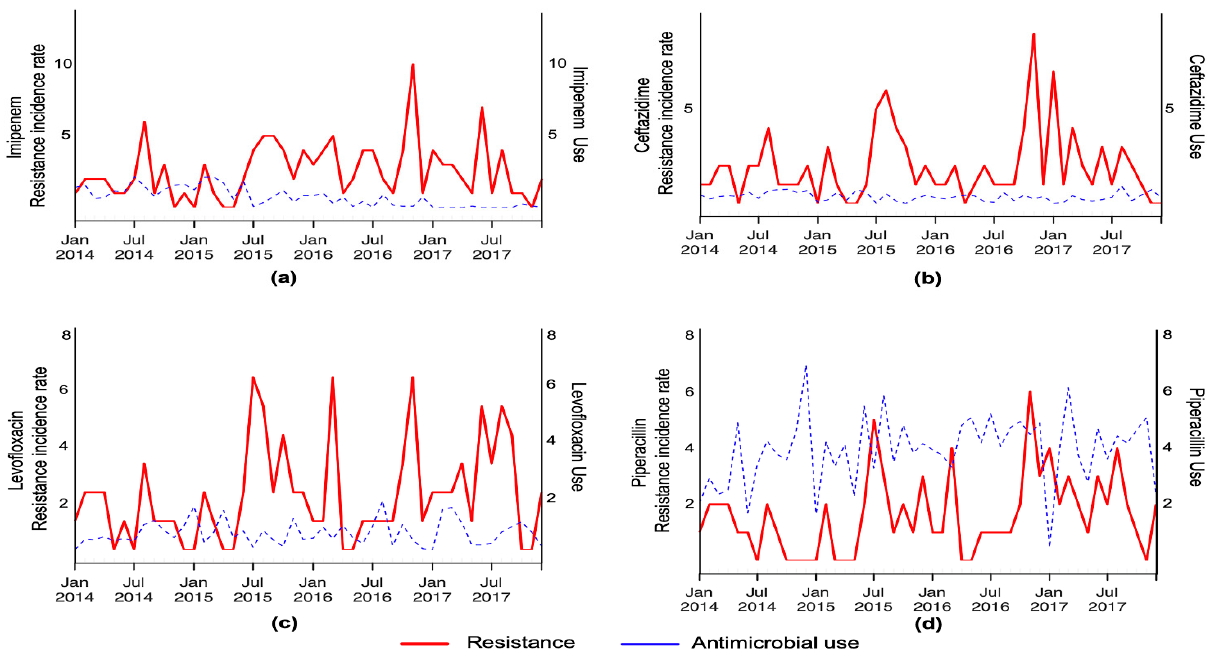
Figure 3. Smoothed monthly resistance detection rate of P. aeruginosa and hospital use of imipenem ( a ), ceftazidime ( b ), levofloxacin ( c ) and piperacillin ( d ).